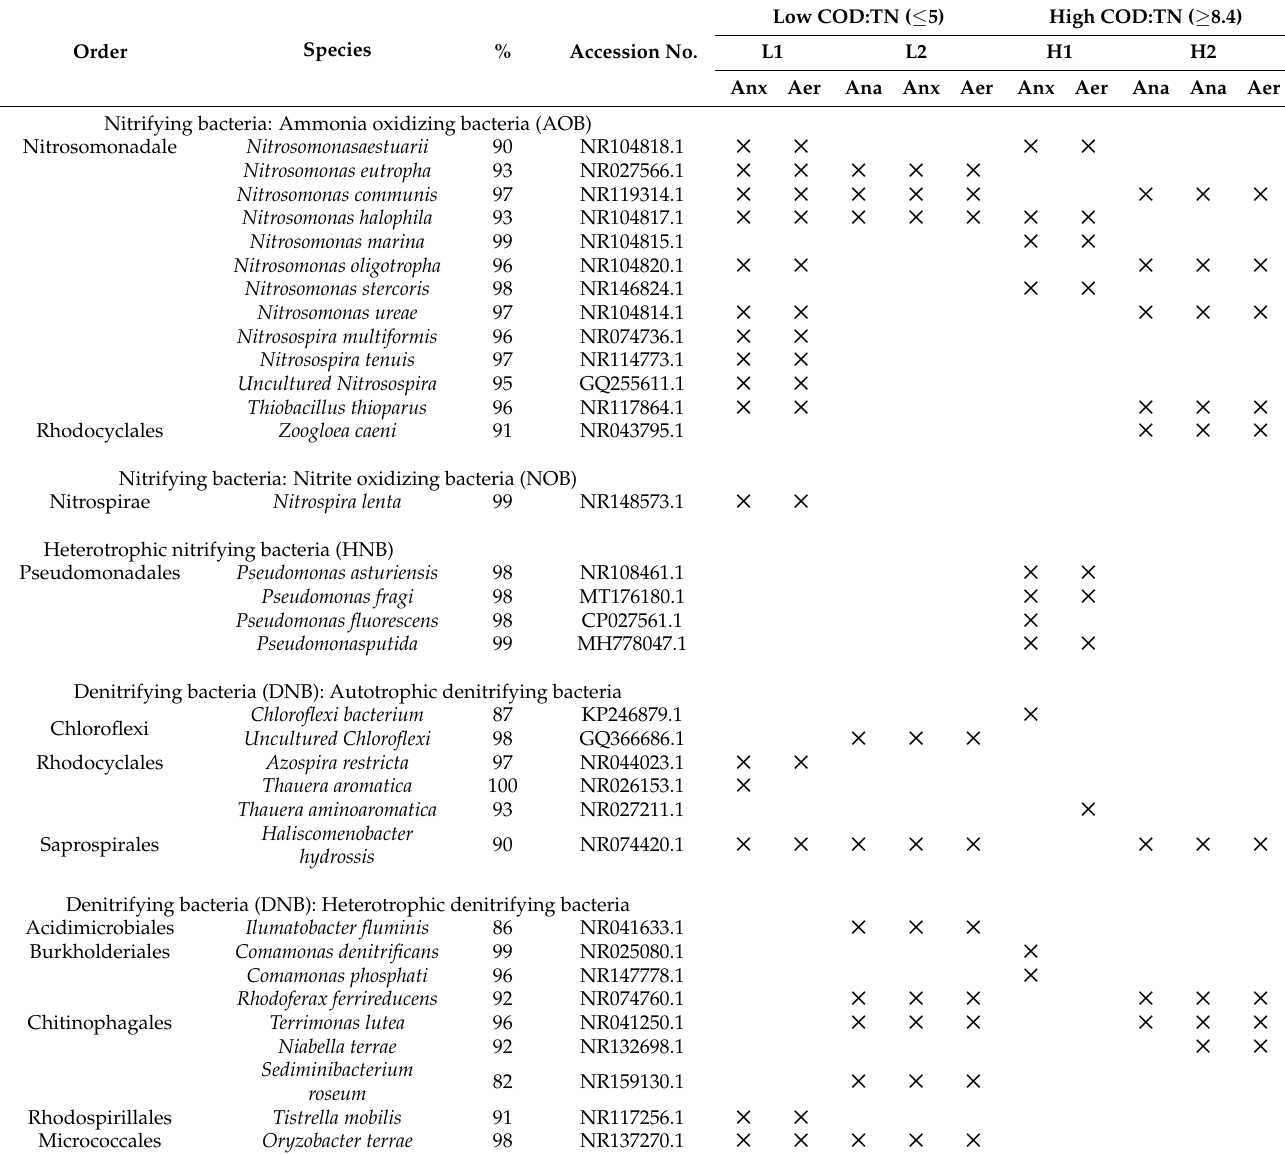
Table 3. Microorganisms’ community in four municipal